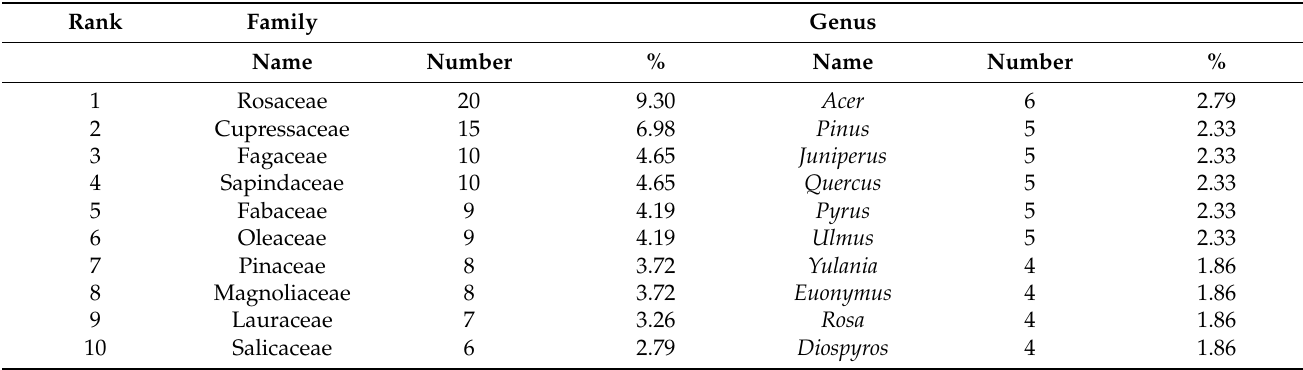
Table 4. The top-ranking ten families and genera with number of heritage tree species in Jiangsu Province, eastern China.